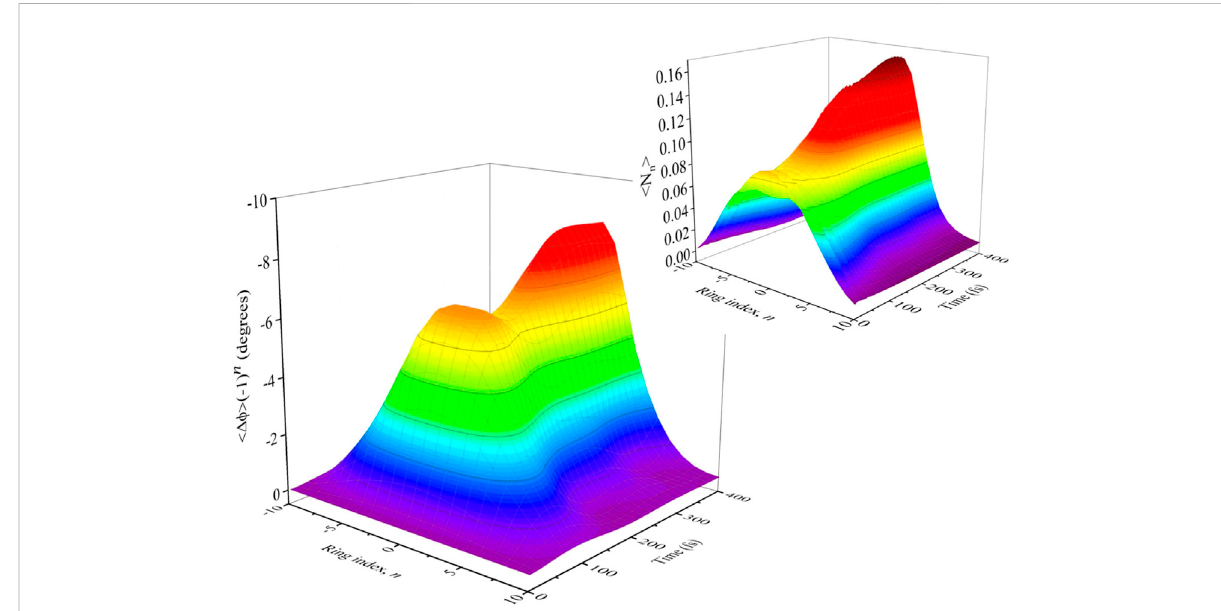
FIGURE 9 The time dependence of the staggered angular displacement, 〈 ϕ n 〉 × ( − 1) n . The change of dihedral angle is Δ θ n = ( ϕ n +1 − ϕ n ), showing local planarization for a PPP chain of 21 monomers. The inset shows the time dependence of the exciton density, 〈 N n 〉 , showing exciton density localization after a single torsional period (~ 200 fs). In the long-time limit (i.e., t ≳ 400 fs) 〈 ϕ n 〉 ∝ 〈 N n 〉 × ( − 1) n , illustrating classical (Landau) polaron formation. Reproduced from J. Chem. Phys. 149, 214107 (2018) with the permission of AIP